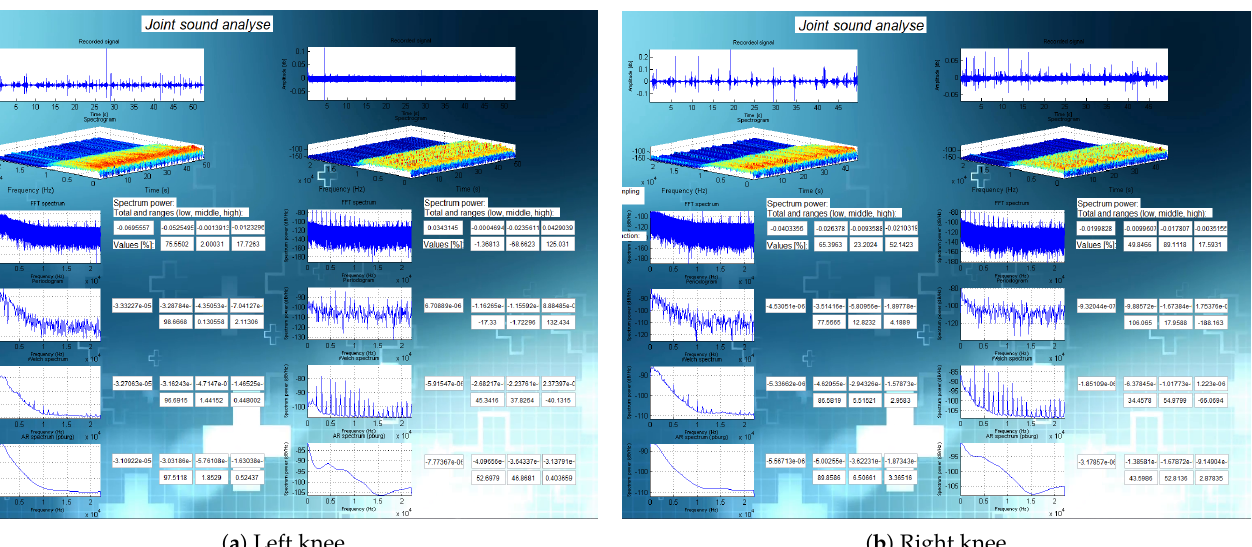
Figure A1. Analysis for subject